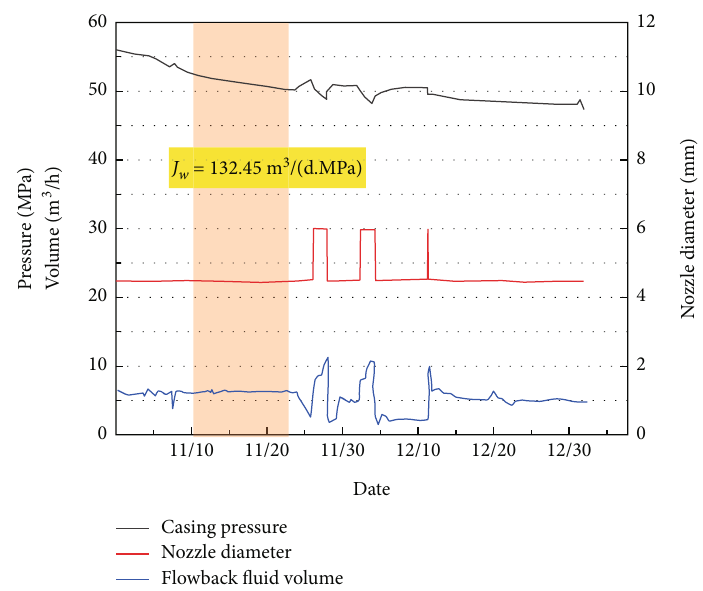
Figure 4: Flowback curve of L2-3 well.